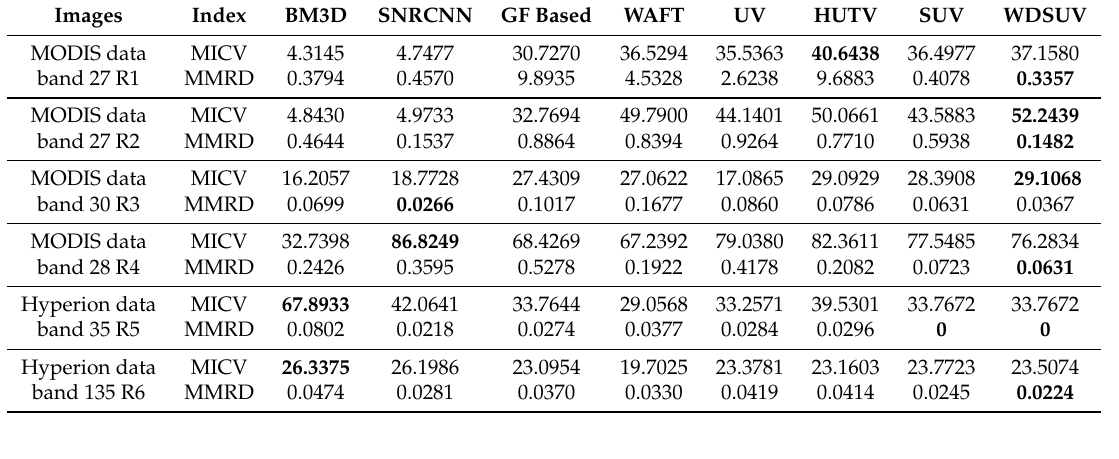
Table 4. Quantitative assessment of real data.